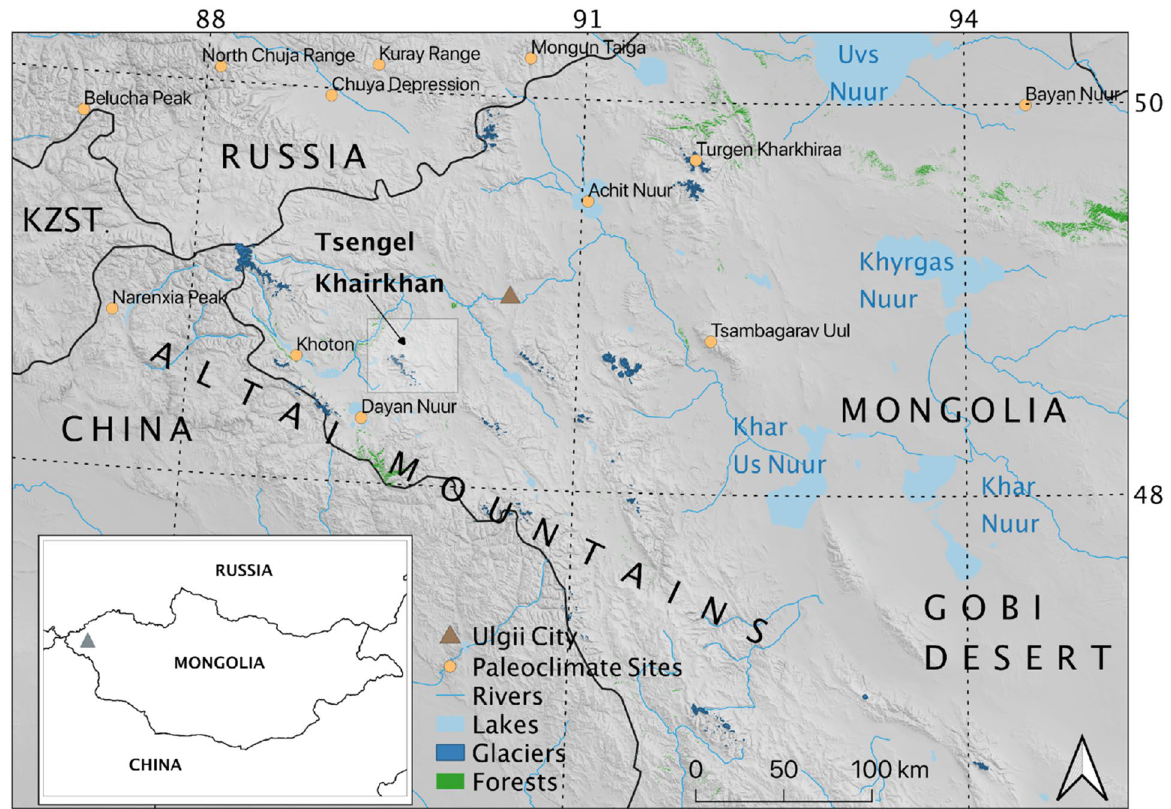
Figure 1. Location of the Tsengel Khairkhan study site and key geographic locations mentioned in the text (including paleoclimate study sites referenced in the Supplementary Material). Produced in QGIS 3.10 (http:// www. qgis.